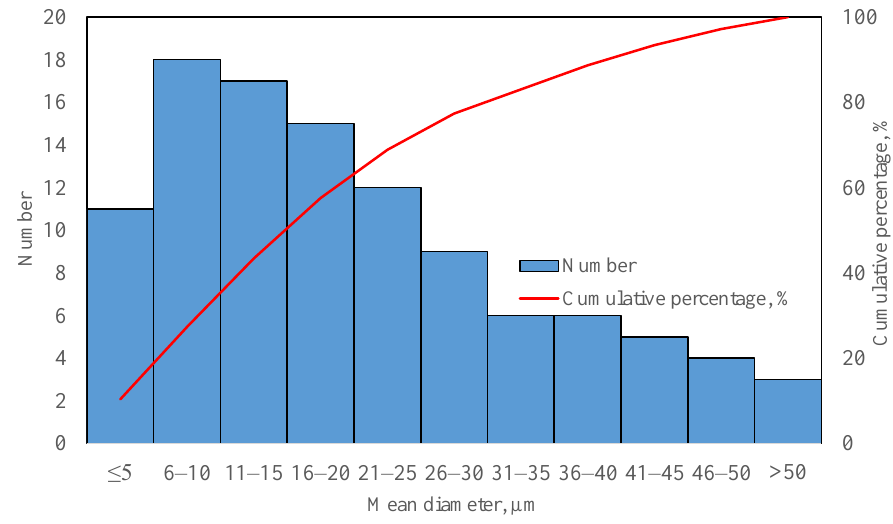
Figure 8. Pore size distribution for SLM sample shown in Figure 7b, obtained via XCT scan. Red curve represents the cumulative pore distribution.